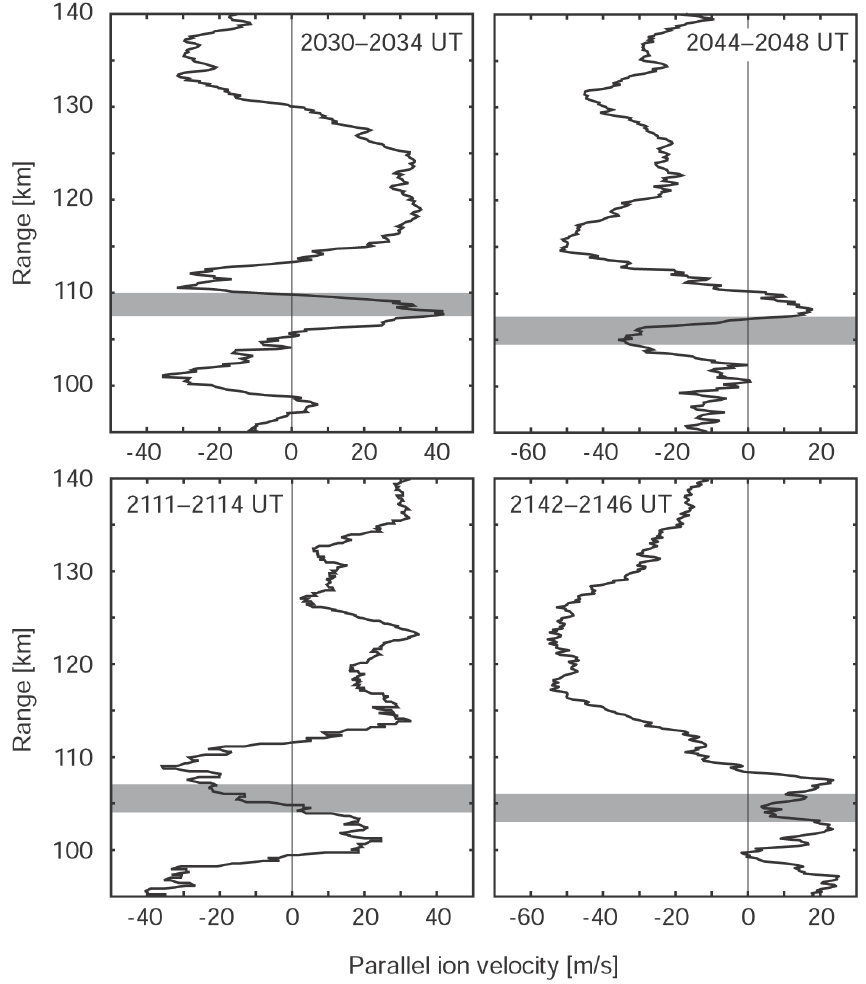
Fig. 7. Field-aligned ion velocity profiles at different time intervals. Positive velocity is upwards. The grey bands show the altitude of the sporadic